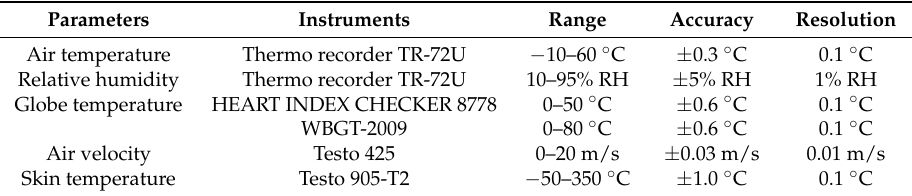
Table 2. Metrological properties of related instruments.